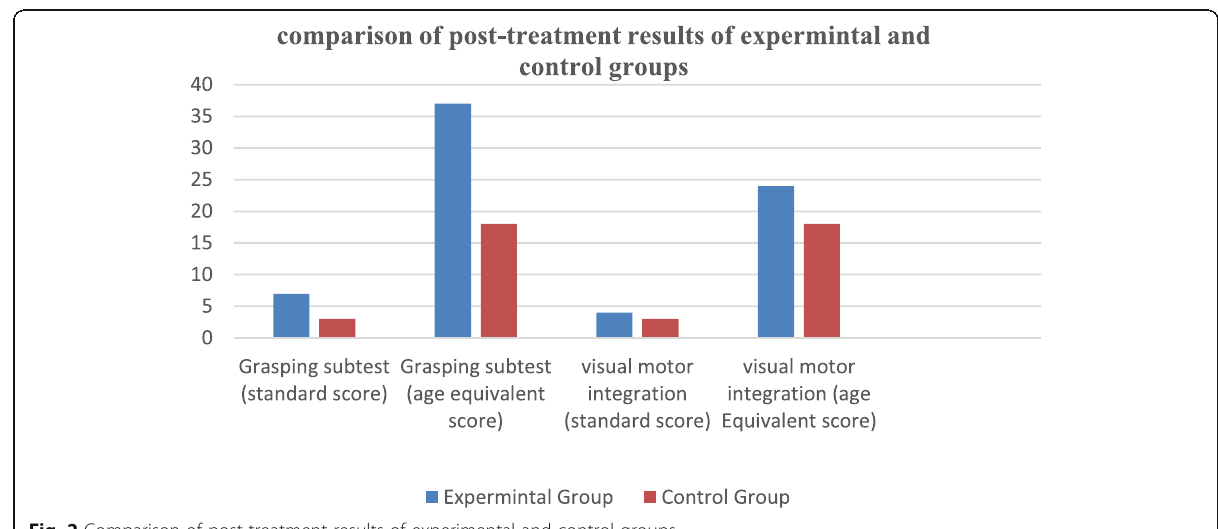
Fig. 2 Comparison of post-treatment results of experimental and control